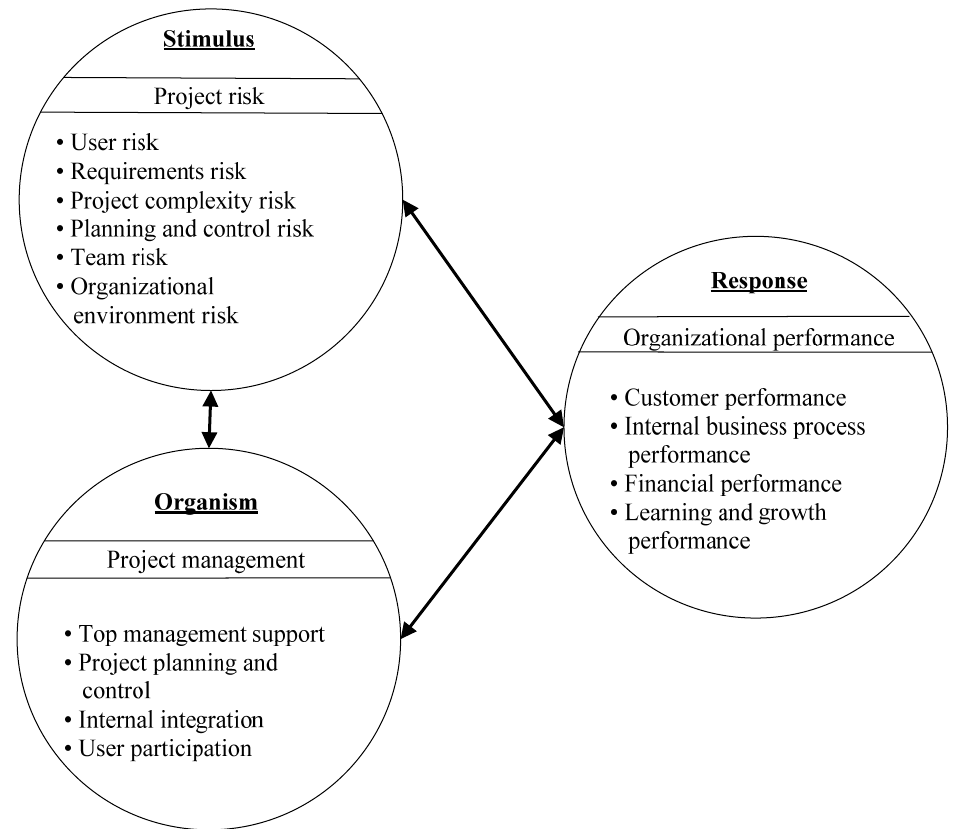
Figure 2. Research framework of this study. Table 4. Dimensions and influential criteria of the research framework.